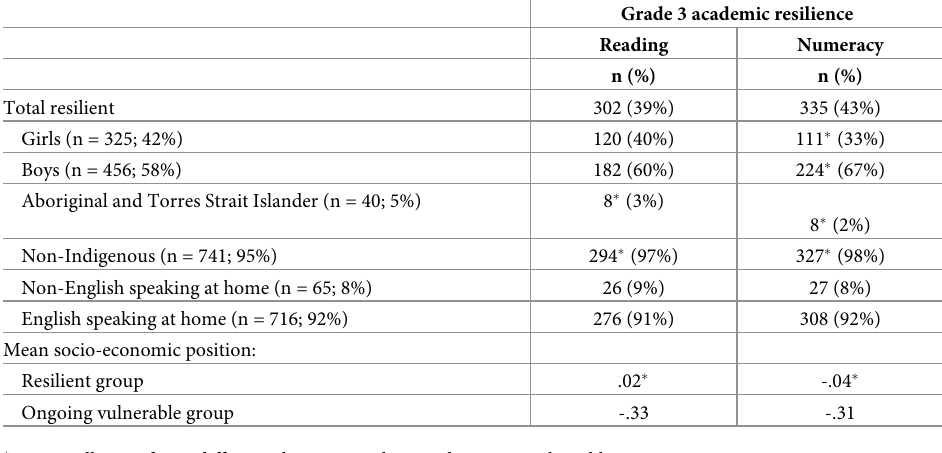
Table 3. Socio-demographic characteristics of resilient children in each academic achievement